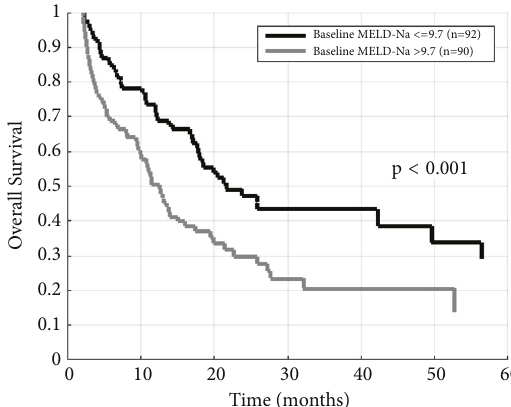
Figure 1: Kaplan-Meier overall survival curves after grouping patients by baseline MELD-Na. p value calculated using log-rank test.